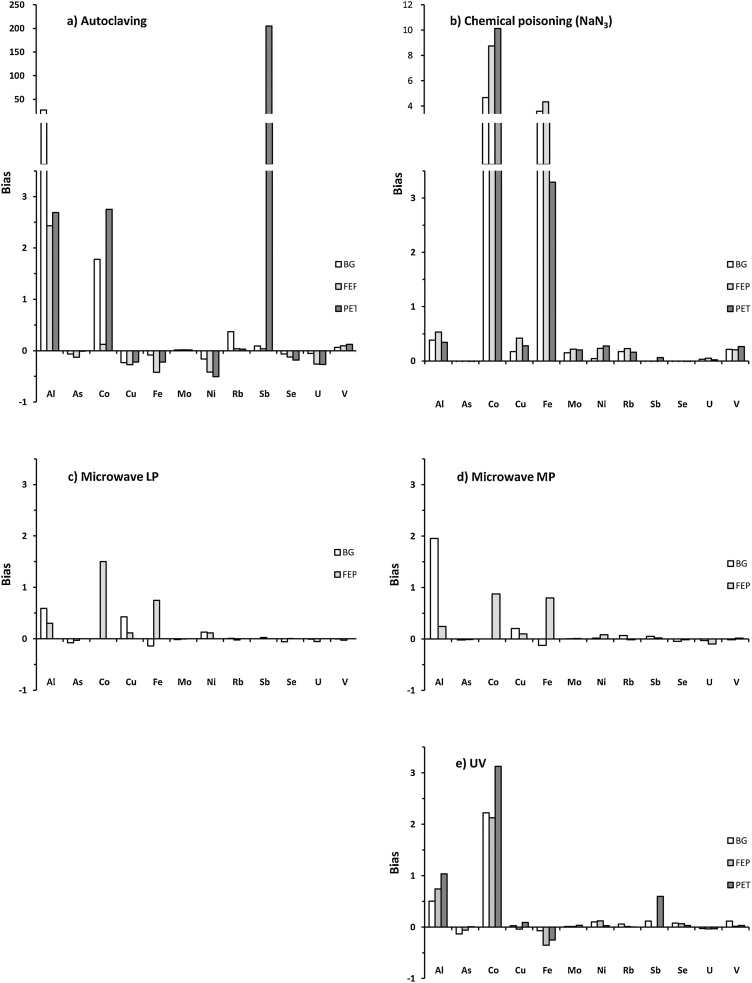
Impact of sterilization processes on chemical balances: (a) Autoclaving, (b) Chemical poisoning (NaN3), (c) Low Power (LP) microwaves, (d) Medium Power (MP) microwaves, (e) UV. Bias represents the normalized difference between trace metals concentrations after the sterilization protocol vs trace metals concentrations in the untreated sample (Control). Sterilization assays were performed in BG (white), FEP (light grey) and PET (dark grey) bottles. Trace metals with concentrations below the analytical limit of detection (Cd, Cr, Pb, Sc, Ti and Zn) are not presented.